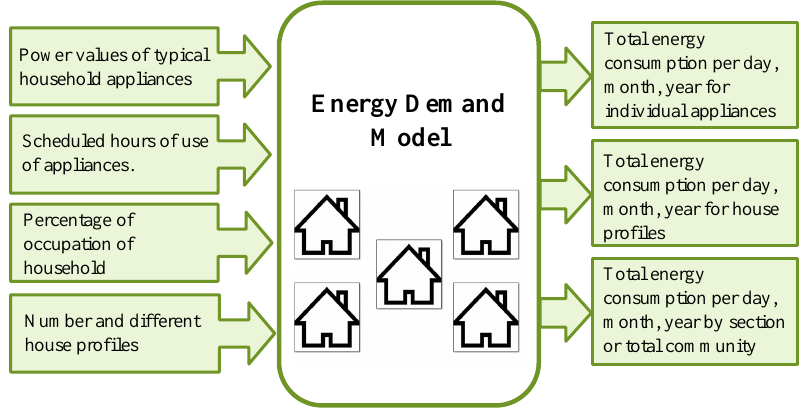
Figure 3. Load profiles model